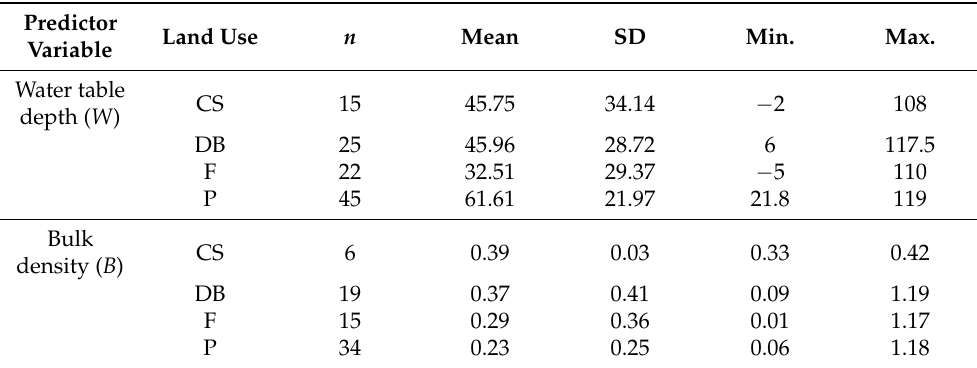
Table A4. Summary statistics of water table depth and bulk density for each land cover class as defined by the MOEF [62]. Variable Land Cover n Min. Max. Bare ground Water table depth ( W . cm)